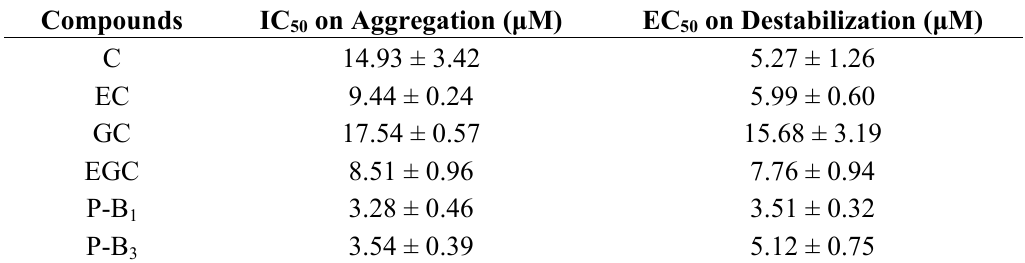
Table 1. IC values for A β 42 aggregation and EC 50 preformed